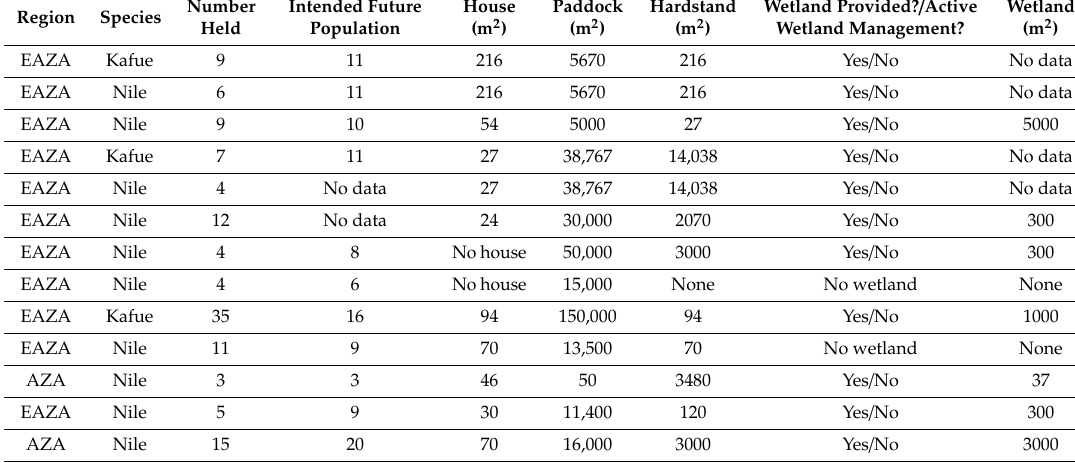
Table 3. Enclosure sizes and wetland features provided to the lechwe in the sample population. Region